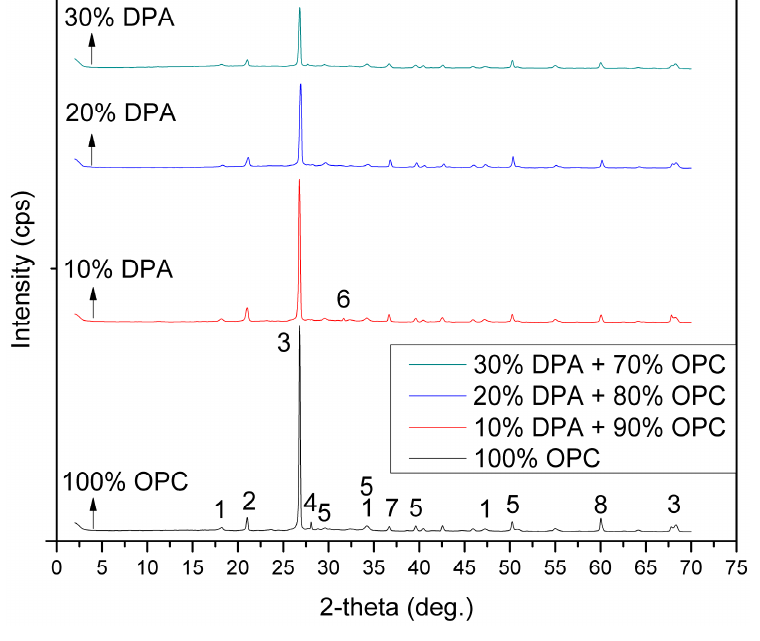
Figure 10. XRD spectra of binders at 28 days. Phases at peak IDs: 1—portlandite, 2—stratlingite, 3— quartz, 4—garronite, 5—C-S-H, 6—wollastonite, 7—hydrotalcite, and 8—C-A-S-H. 3—quartz, 4—garronite, 5—C-S-H, 6—wollastonite, 7—hydrotalcite, and